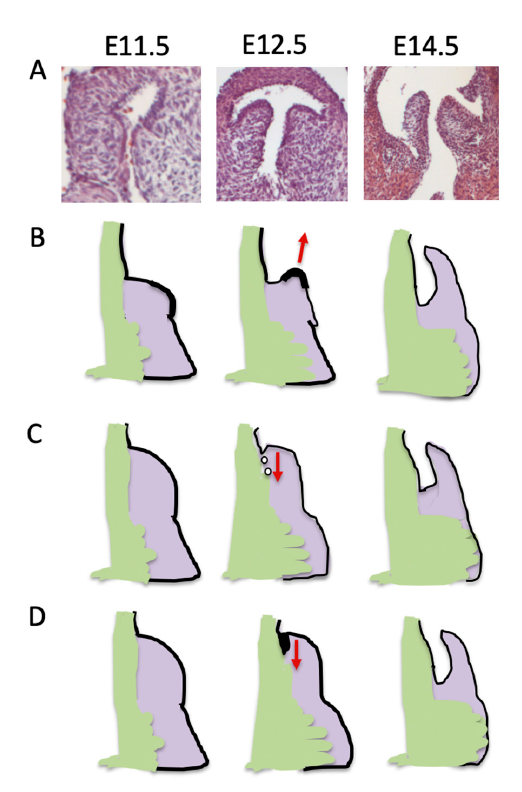
Figure 5. Models of valve sculpting . ( A ) Histological images showing how the leaflet sculpts from a bulky cushion at E11.5, to a well-defined leaflet by E14.5. ( B ) The leaflet elongation model